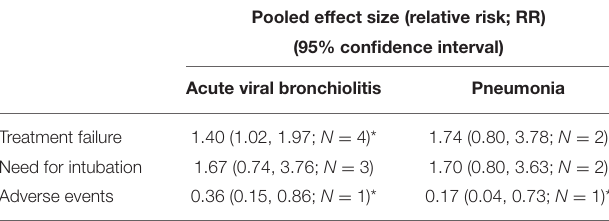
TABLE 2 | Findings of subgroup analysis for the primary outcomes based on clinical diagnosis. Pooled effect size (relative risk;